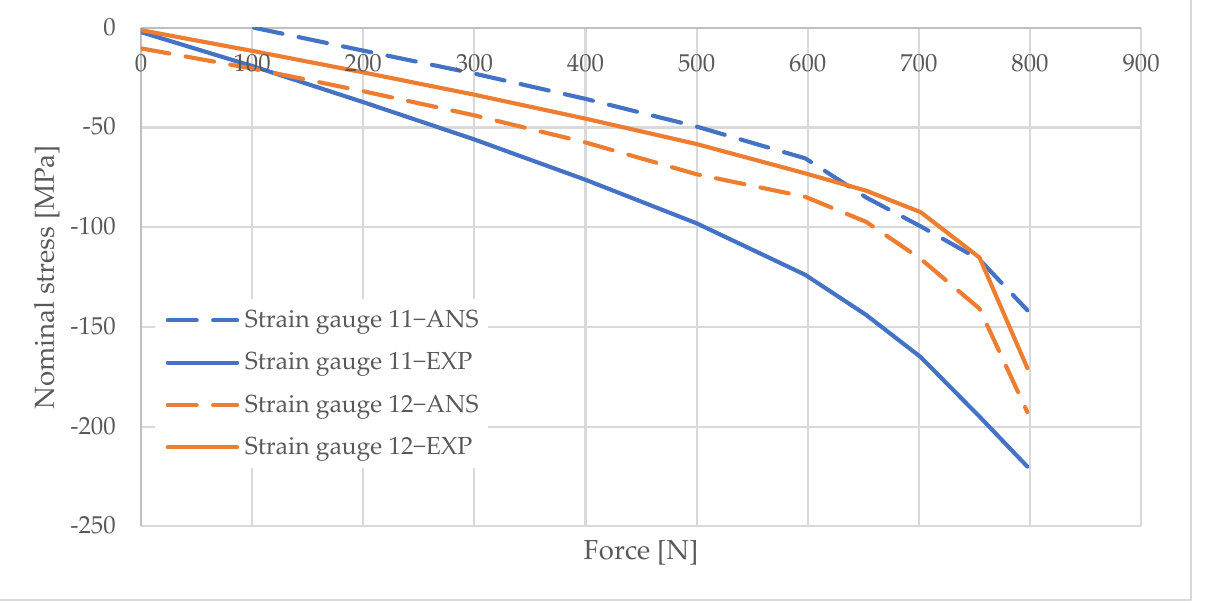
Figure 14. Pole 9/1 — values of normal stress readings from strain gauges no. 1, 4, and 7.